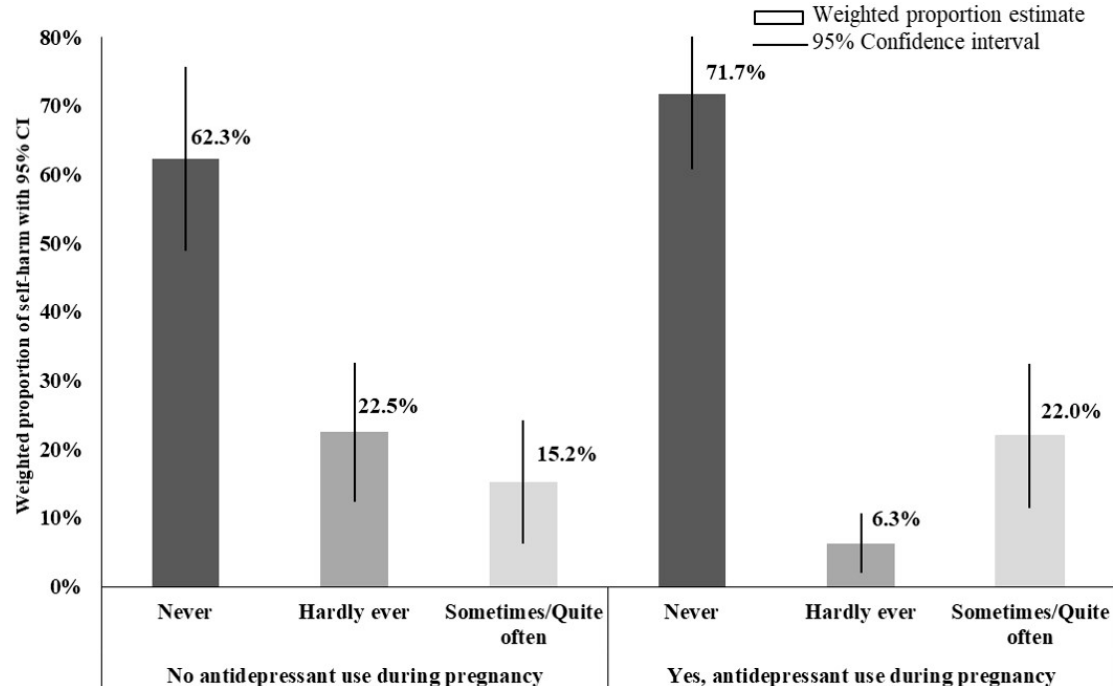
Figure 2. Weighted proportion of frequency of self-harm ideation by antidepressant use among 187 women with depres- sion/anxiety during pregnancy. Magnitude of proportions may not directly align with number of women in the various categories because proportions are weighted via survey weighting method. Antidepressants included all selective serotonin re-uptake inhibitors (SSRIs, ATC code N06AB), serotonin and norepinephrine reuptake inhibitor (SNRI, ATC codes N06AX, venlafaxine and duloxetine), tricyclics (TCA, ATC code N06AA), and unspecified antidepressant (ATC code N06A-).